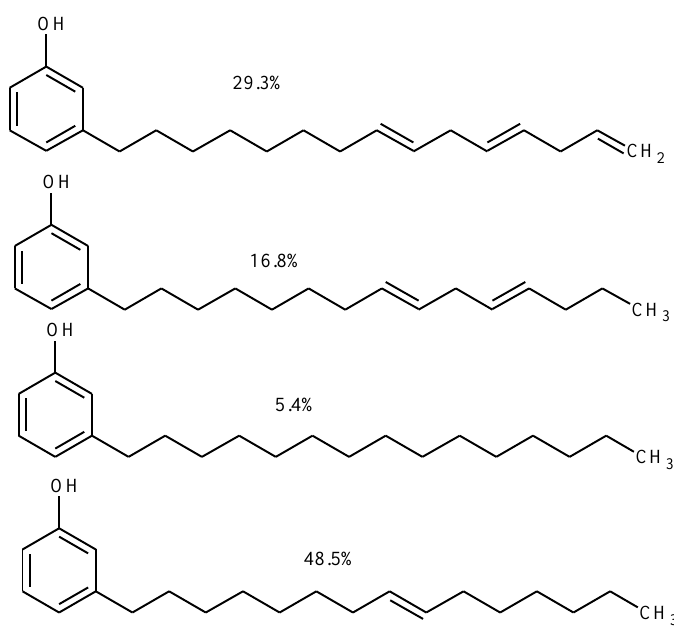
Figure 1. Structure and composition of cardanol.